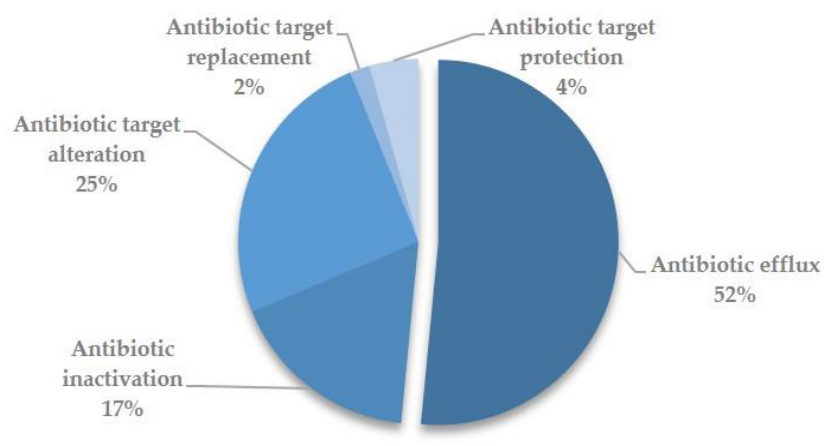
Figure 1. Pie chart of molecular determinants involved in antibiotic resistance mechanisms of SAR Bari draft genome.